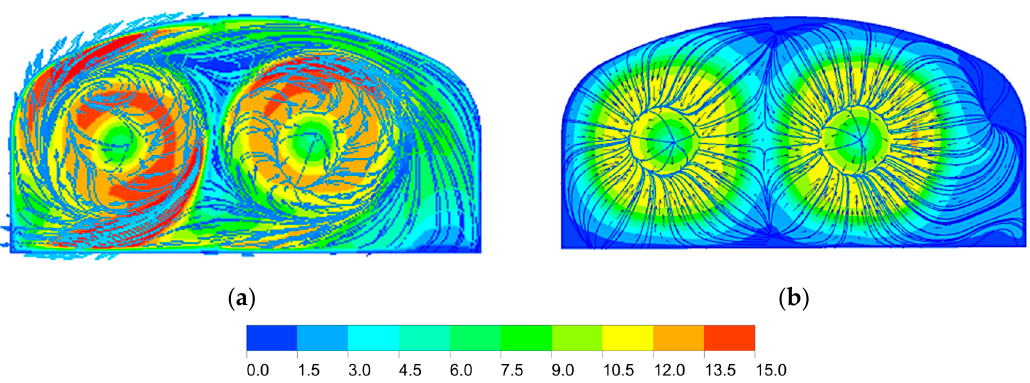
Figure 9. Velocity contours at the position of fans entries. ( a ) Q = 60 m 3 /s; ( b ) Q = 80 m 3 /s.